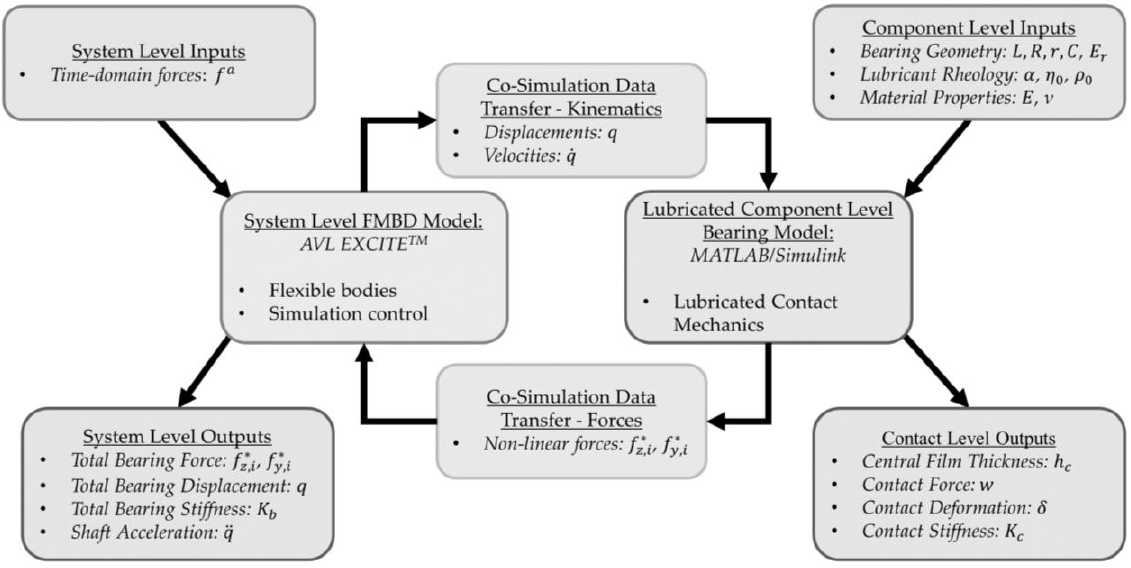
Figure 1. Flowchart of Models.